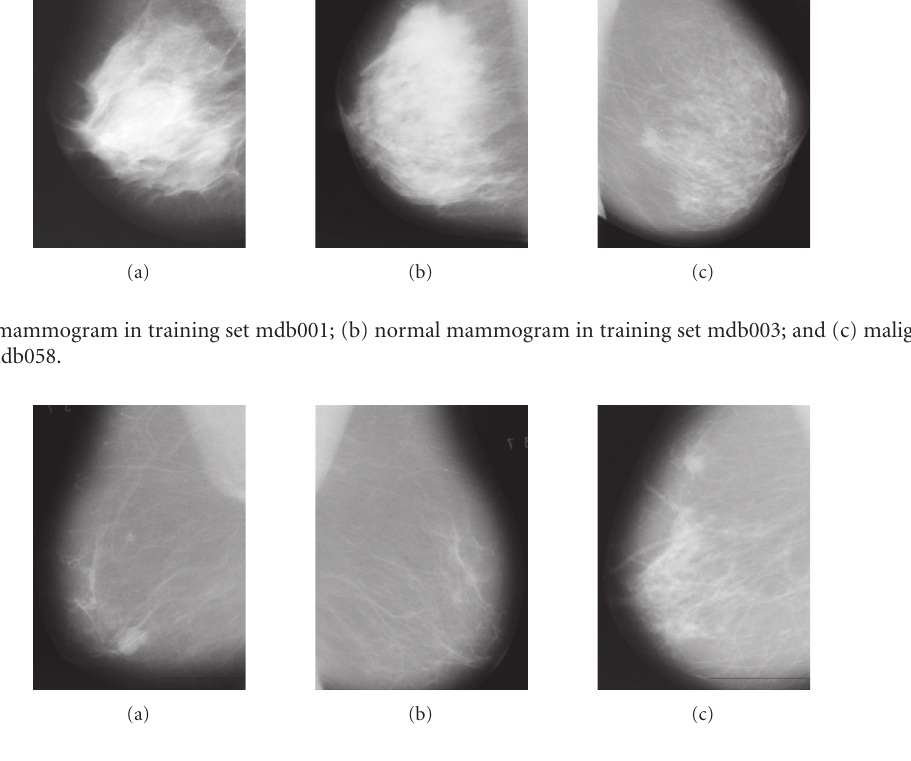
Figure 2: (a) Benign mammogram in testing set mdb005; (b) normal mammogram in testing set mdb006; and (c) malignant mammogram in testing set